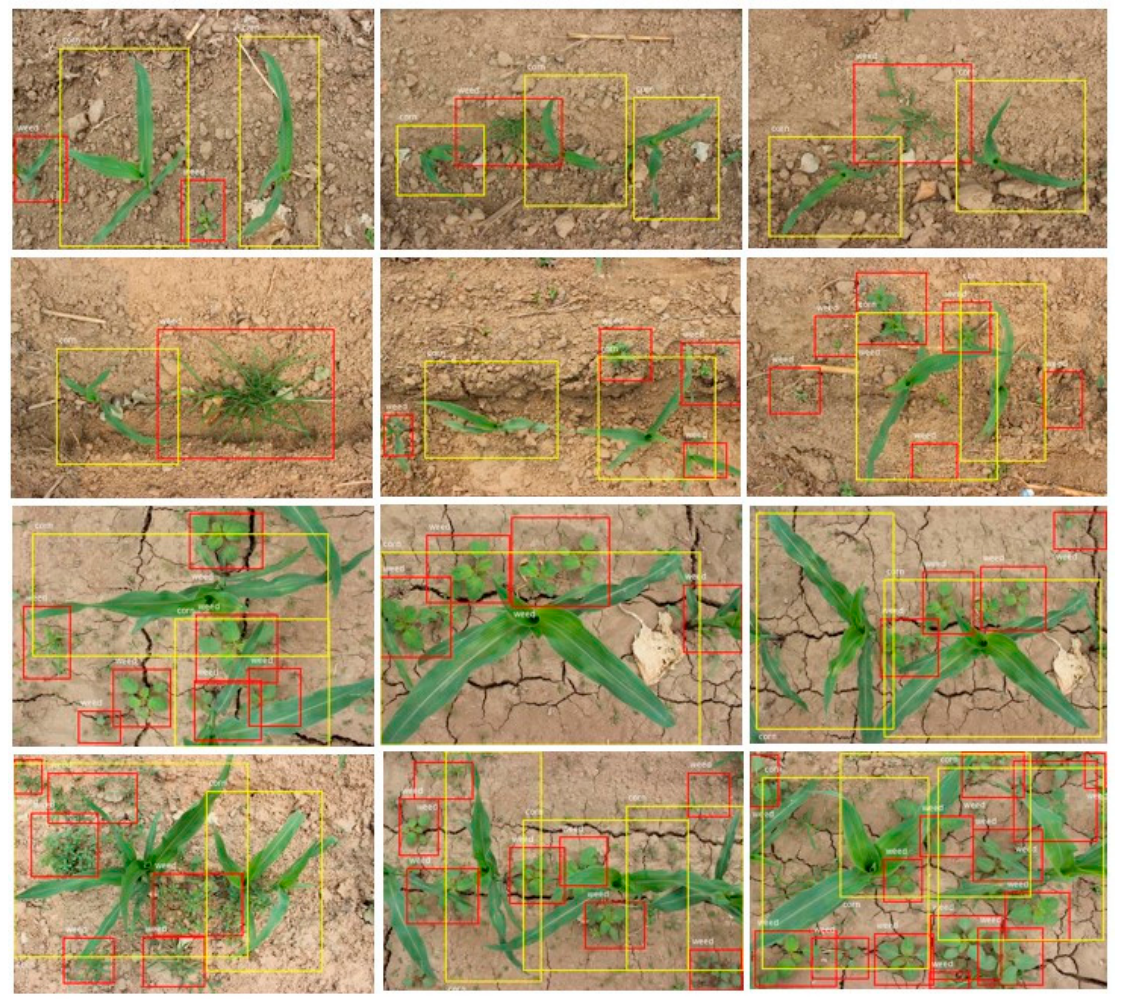
Figure 12. Experimental effect IV.